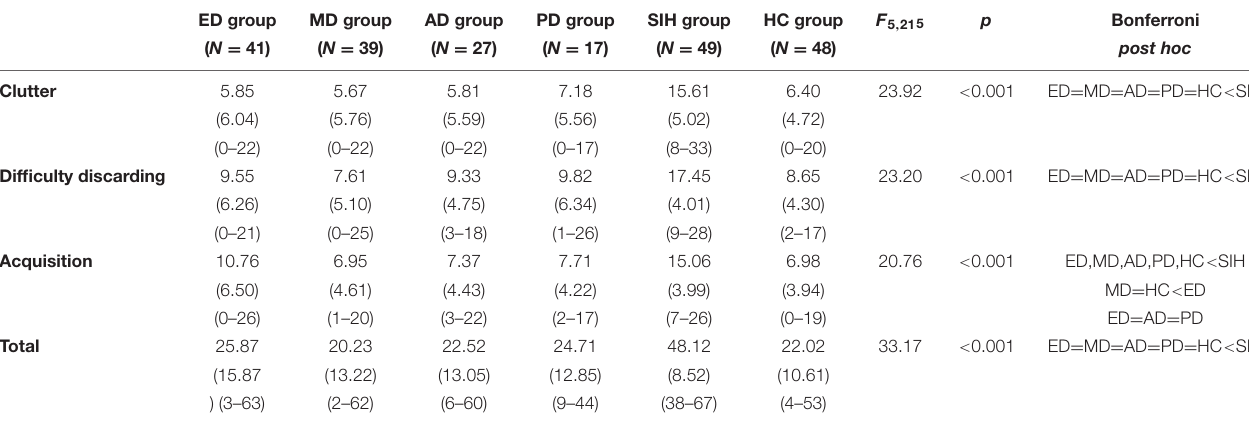
TABLE 2 | Means, standard deviations (SD), ranges and Bonferroni post hoc comparisons for the Saving Inventory-Revised (SI-R) Total and subscales scores obtained by the 6